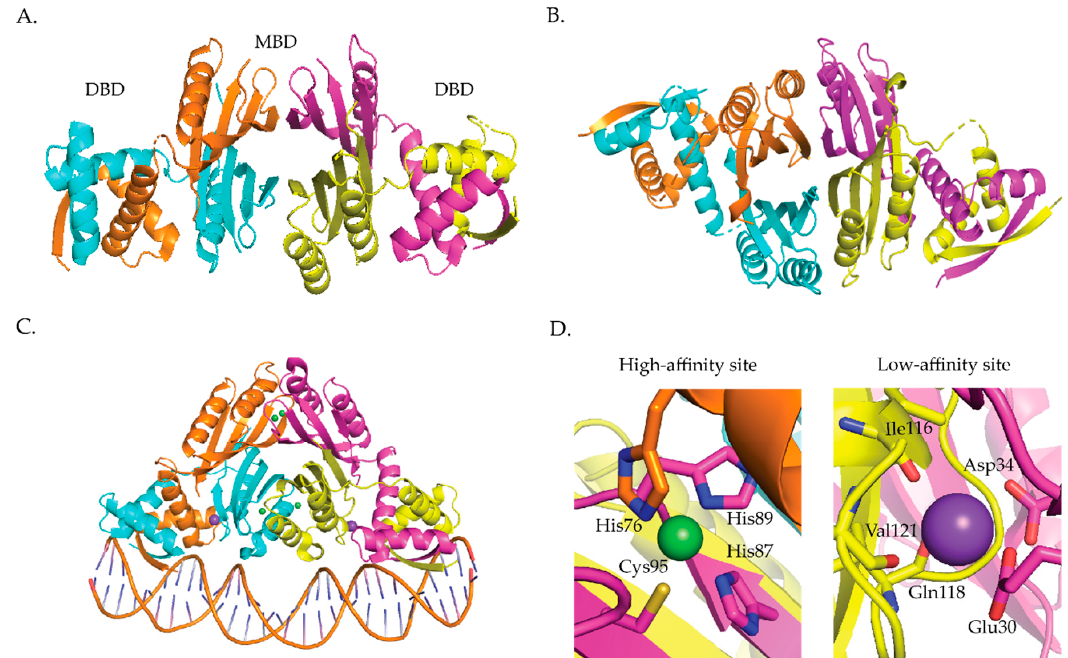
Figure 3. NikR proteins from E. coli , and H. pylori showing different conformations. The NikR monomers are colored in orange, blue, purple, and yellow, the nickel ions are shown as green spheres and the potassium ions are shown as purple spheres. ( A ) Apo E. coli NikR (PDB ID 1Q5V) [45] in an open conformation where the DBDS are placed linearly on each side of MBD. ( B ) H. pylori Ni(II)-NikR (PDB ID 2CAD) [54] depicting a closed trans-conformation. ( C ) E. coli NikR bound to DNA, nickel